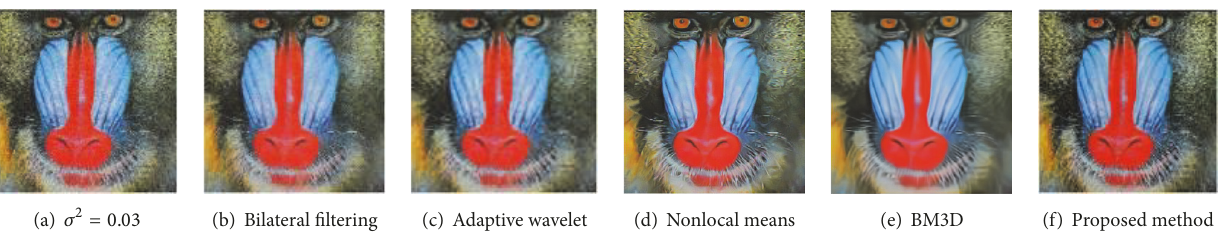
Figure 8: Image 5: comparison of various experimental results under noise variance 𝜎 2 = 0.03 .